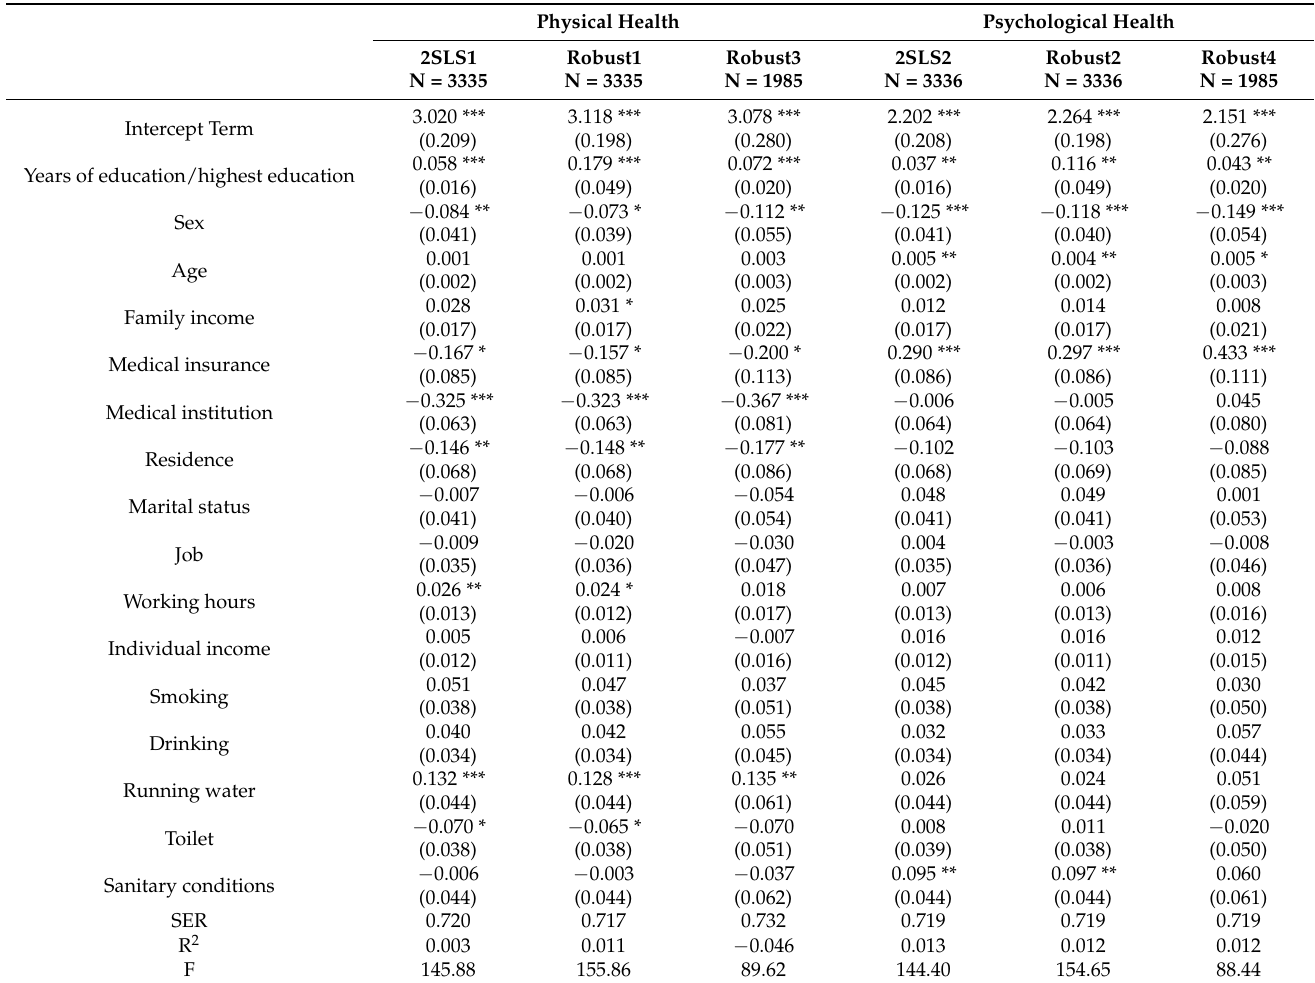
Table 4. Results of the robustness